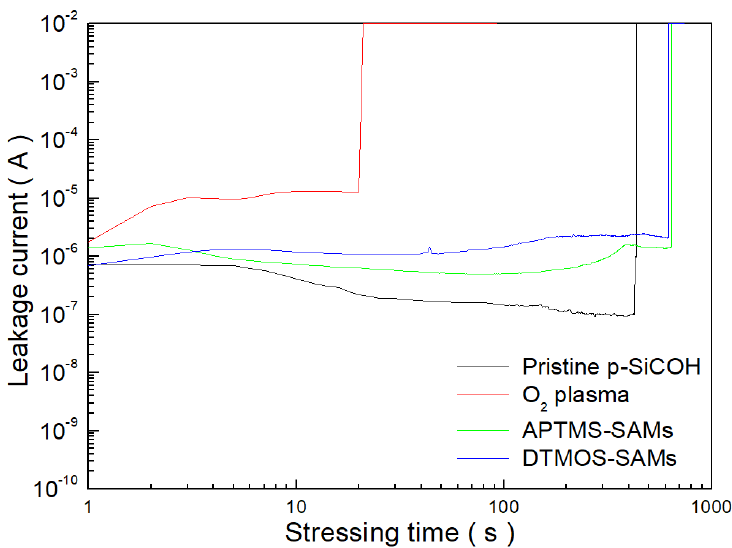
Figure 5. Plots of leakage current versus the stress time ( I-t ) for pristine, O 2 plasma-irradiated, APTMS-SAMs, and DTMOS-SAMs p-SiOCH films under TDDB tests.